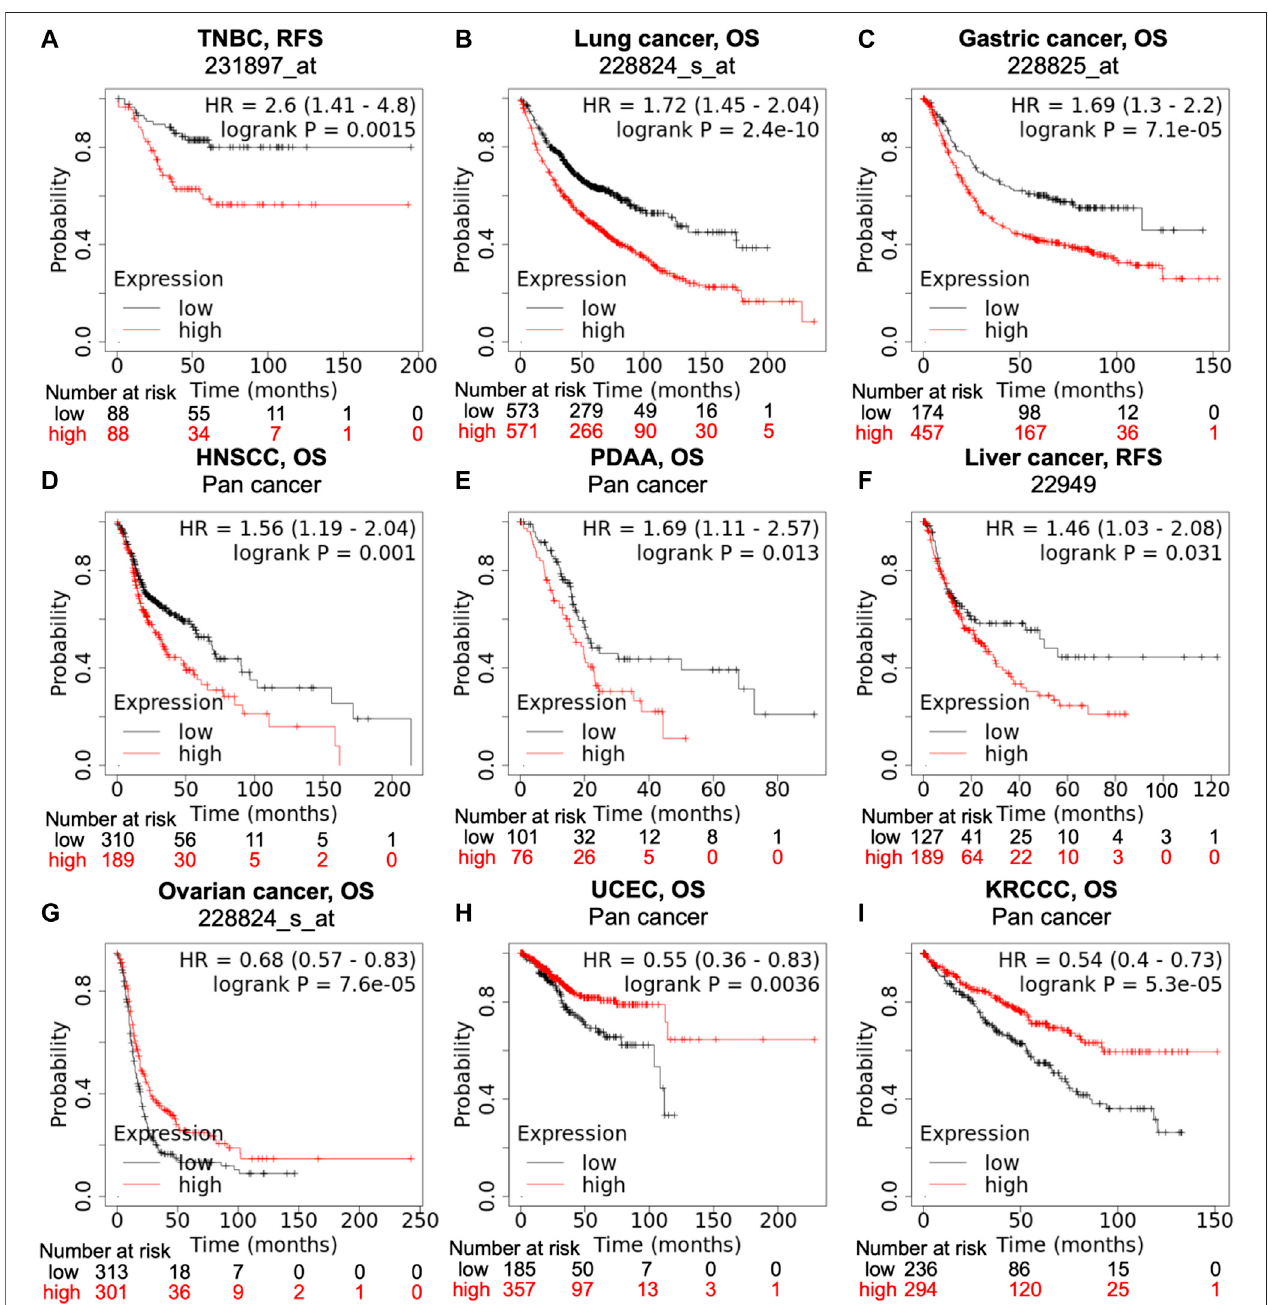
FIGURE 2 | Correlation of PTGR1 expression level with cancer prognosis. Kaplan-Meier survival curves compare with the high and low expression of PTGR1indifferenttypesofcancerintheKaplan-Meierplotter (A,B,C,F,andG) andpancancerdatabases (D,E,H,andI) . (A – F) HighPTGR1expressionwascorrelated with poor RFS in TNBC and liver cancer, and poor OS in lung cancer, gastric cancer, HNSCC, and PDAA. (G – I) Low PTGR1 expression was correlated with poor OS in ovarian cancer, UCEC, and KRCC. Triple-negative breast cancer, TNBC; head-neck squamous cell carcinoma, HNSCC; pancreatic ductal adenocarcinoma, PDAA; uterine corpus endometrial carcinoma, UCEC; kidney renal clear cell carcinoma, KRCCC. OS, overall survival; RFS, relapse-free survival.